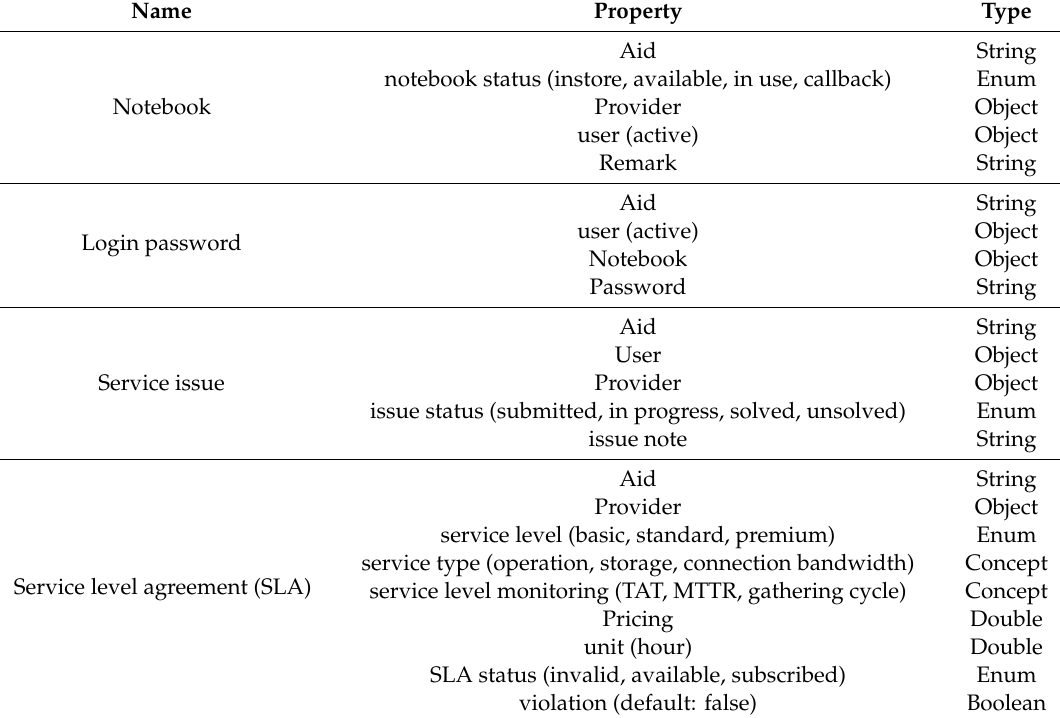
Table 2. Asset definition in the smart